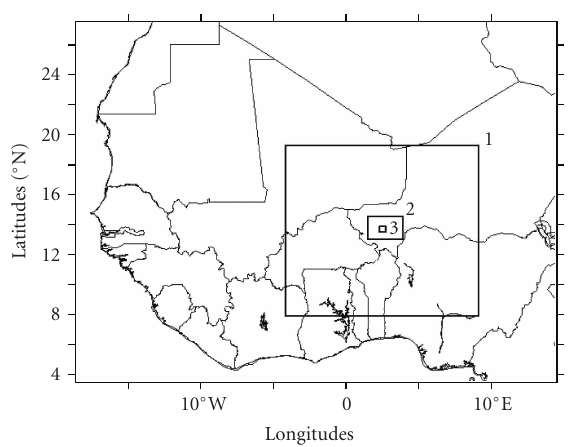
Figure 1: The full experimental domain over West Africa where Noah-WRF is applied in nesting mode. The two coarse grids (1 and 2) used in this study are shown as well as Dantiandou Kori (grid 3, the evaluation